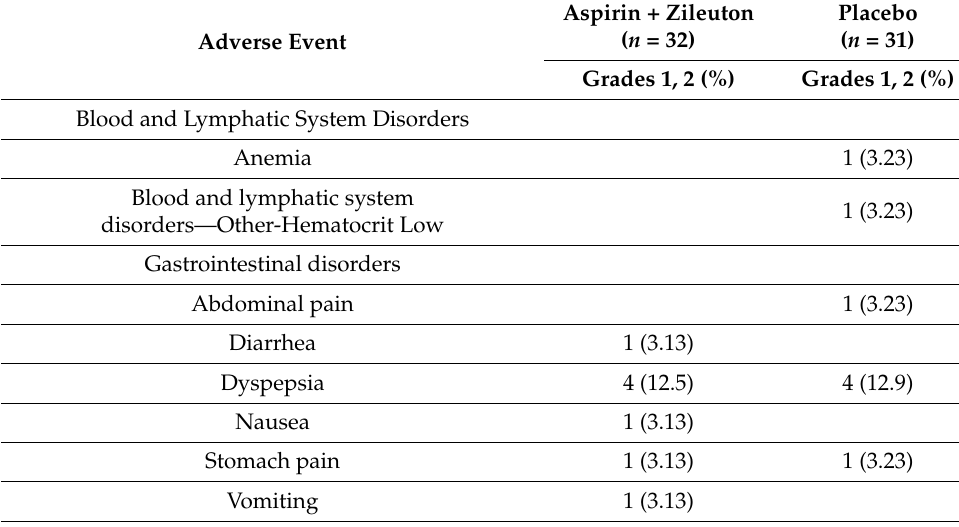
Table 3. Summary of study intervention-related adverse